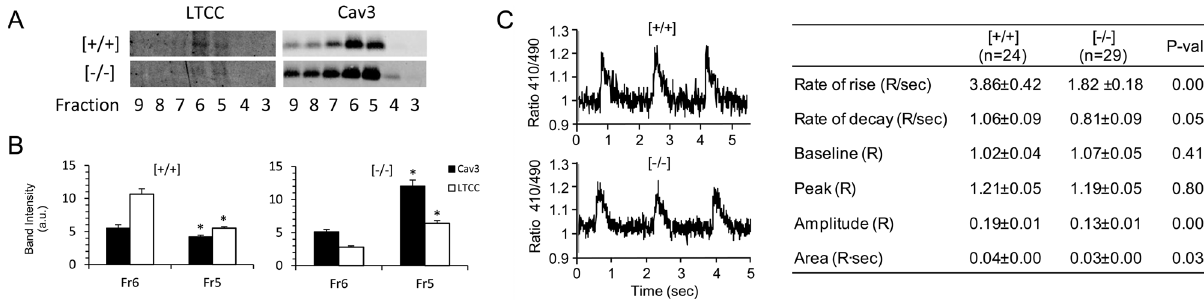
Figure 5. LTCC density sedimentation and [Ca 2 + ] i transients in Popdc1-null cardiomyocytes. (a) Representative WB depicting the sedimentation pattern of LTCC (Cav1.2a, , 200 kDa) and Cav3 ( , 22 kDa) in membrane preparations of WT [ + / + ] and Popdc1 -null [ 2 / 2 ] hearts. (b) Quantification of the relative distribution of LTCC and Cav3 in gradient fractions 5 (Fr5) and 6 (Fr 6) of the two genotypes. The results summarize, in arbitrary units (a.u.), three and five independent experiments for LTCC and Cav3, respectively. *P , 0.05, fraction 5 vs. fraction 6 within each genotype. (c) Left, [Ca 2 + ] i transients in representative cardiomyocytes; Right, summary of the measurements performed; n=number of cells; Mean 6 SEM.